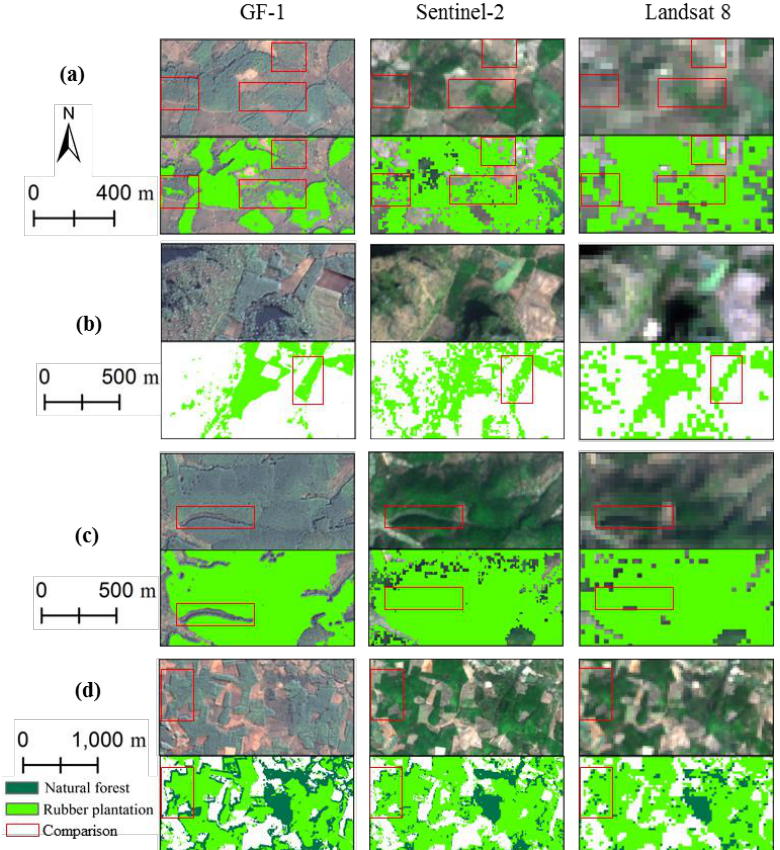
Figure 8. Comparison of rubber plantation maps using GaoFen-1 (GF-1), Sentinel-2, and Landsat 8 imagery.